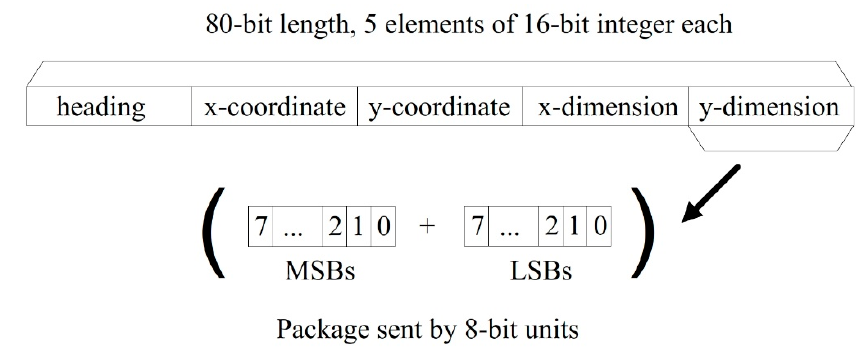
Figure 5. Schematic representation of the information package sent out from the machine vision module. The heading is used to avoid communication errors. Each 16-bit element is sent by two 8-bit units: Most Significant Bits (MSBs) plus Less Significant Bits (LSBs).